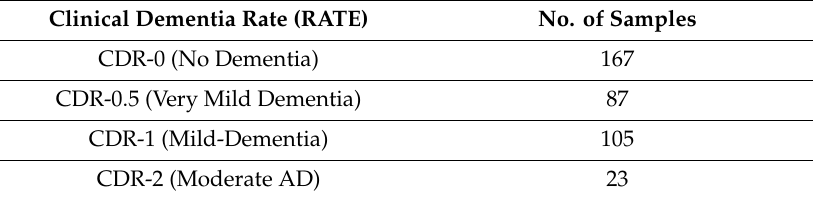
Table 2. Summary of the global clinical dementia rating (CDR).